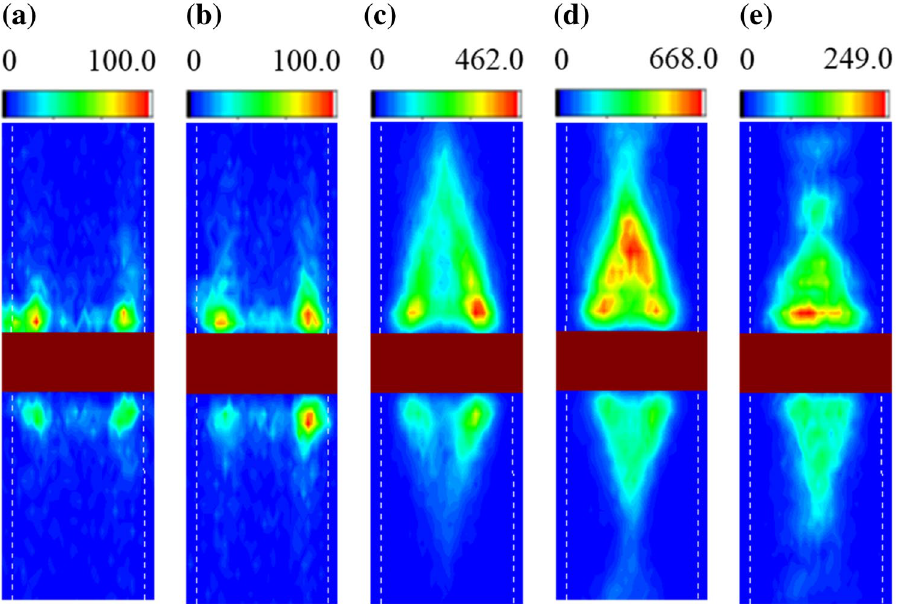
Figure 5. Spatial profiles of Brillouin light scattering spectrum with various RF frequencies in the two blocks with identical dimensions: ( a ) 7.6 GHz ( b ) 7.9 GHz ( c ) 8.4 GHz ( d ) 8.8 GHz and ( e ) 9.4